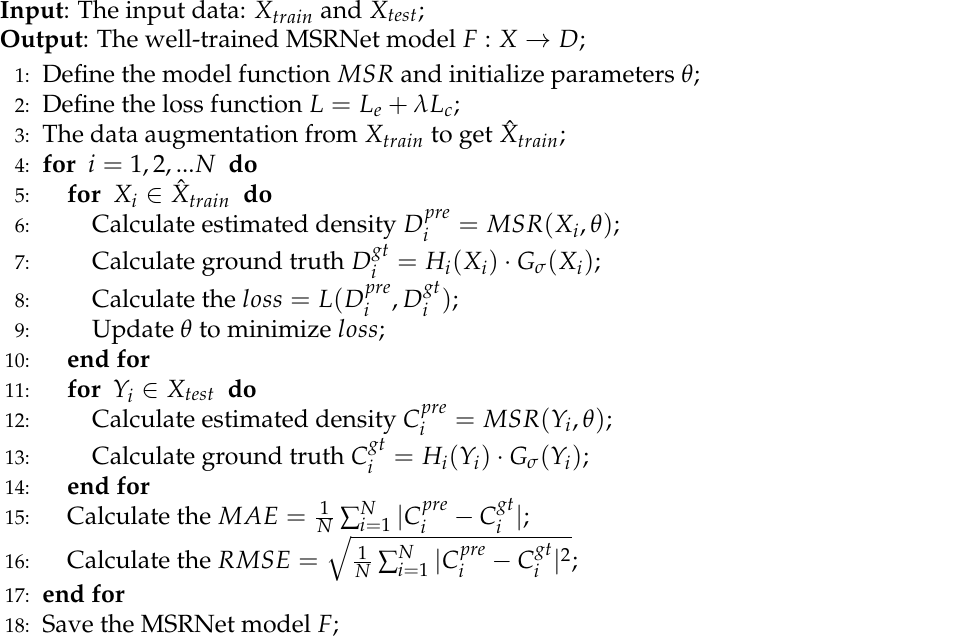
Algorithm 1 Multi-scale residual cattle density estimate network (MSRNet)